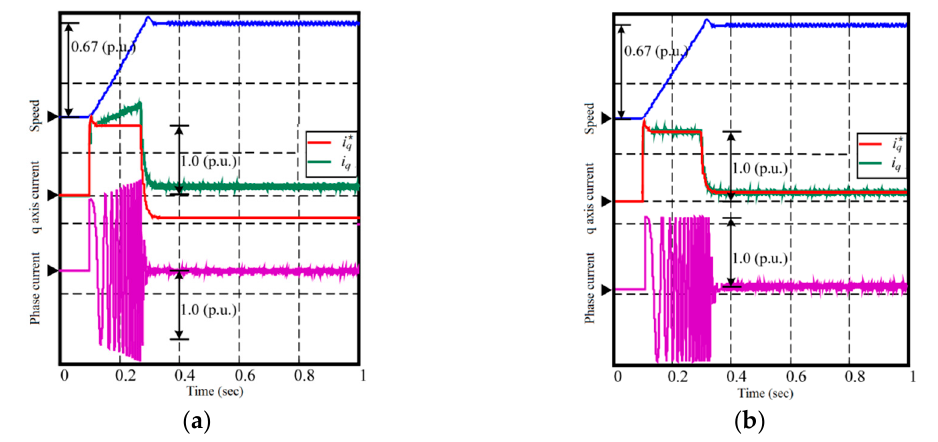
Figure 4. Simulation results of motor starting with mismatched resistance: ( a ) TBC; ( b ) AIBC_FP.